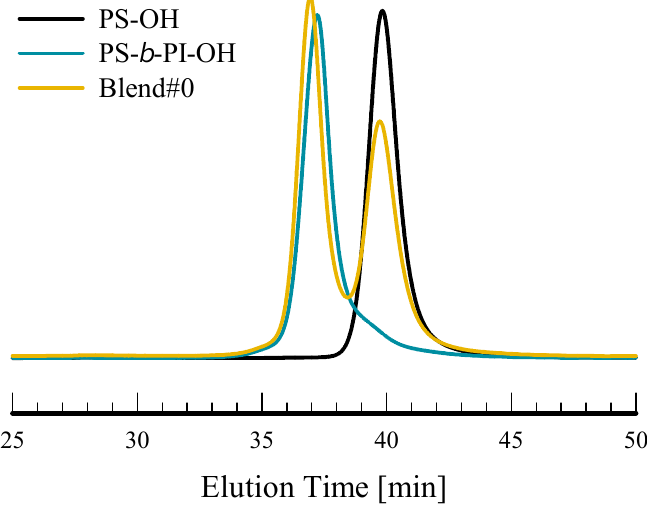
Figure 8. SEC traces of the samples PS ‐ OH, PS ‐ b ‐ PI ‐ OH, and Blend #0.